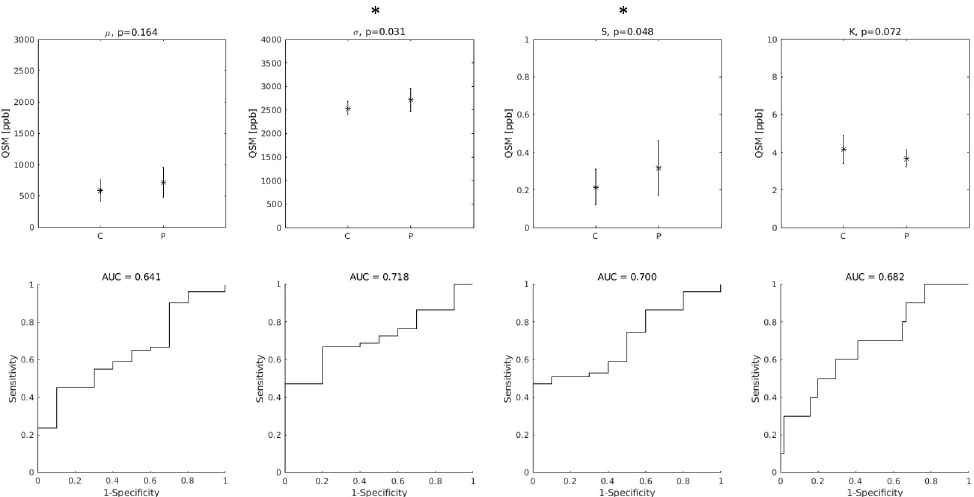
Figure 2. (Top row): group differences between Controls (C) and ALS patients (P) in the distribution indices of M1 QSM values. µ : mean value; σ : standard deviation; S: skewness; K: kurtosis. Asterisks (*) indicate statistically significant differences. (Bottom row): diagnostic accuracy of each feature. AUC: Area Under the Receiver-Operating-Characteristic